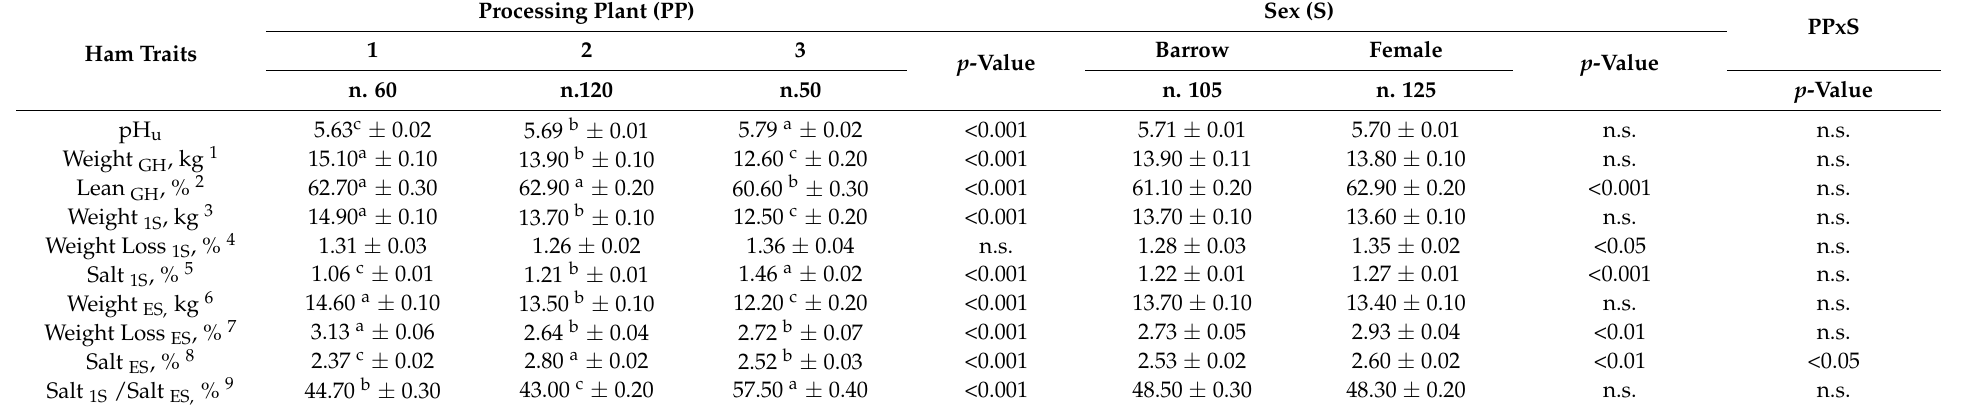
Table 1. Effect of the processing plant (PP) and sex (S) of the animals on the traits (Estimated Marginal Means ± standard error) of hams (green and after salting steps).